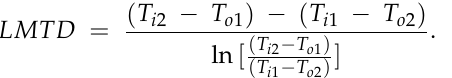
Table 3. The estimated uncertainties.